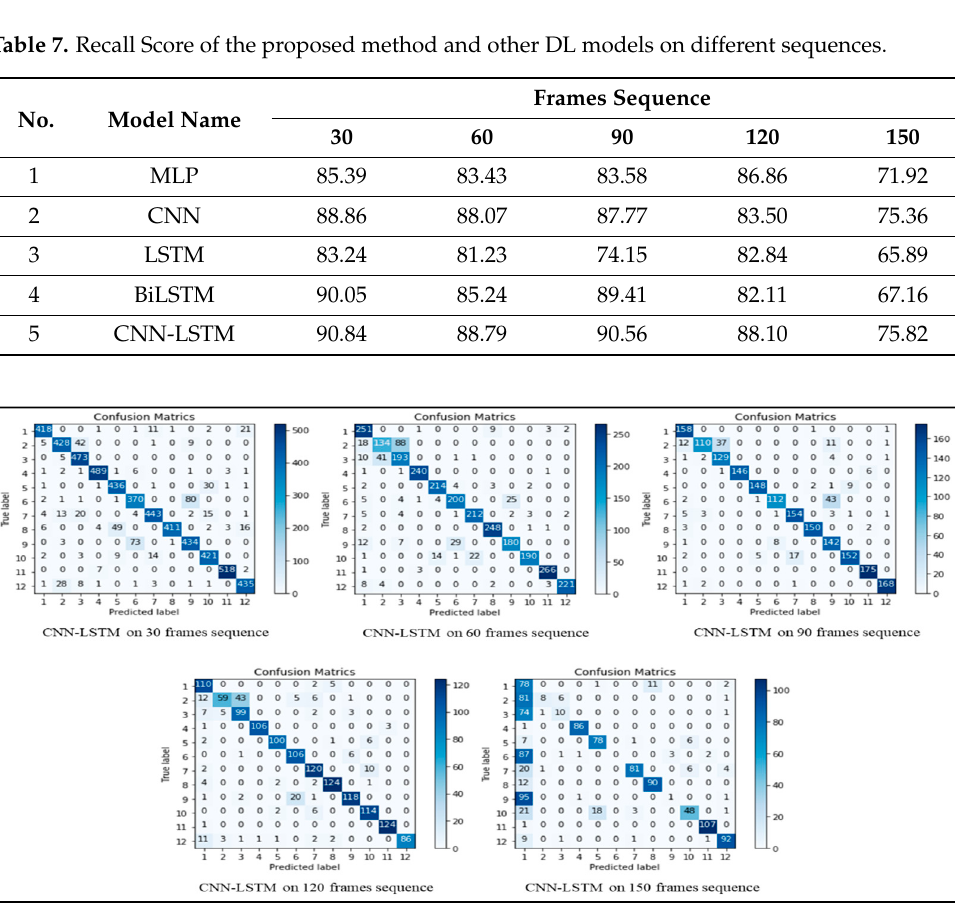
Figure 7. Confusion of CNN-LSTM on different frames sequences.